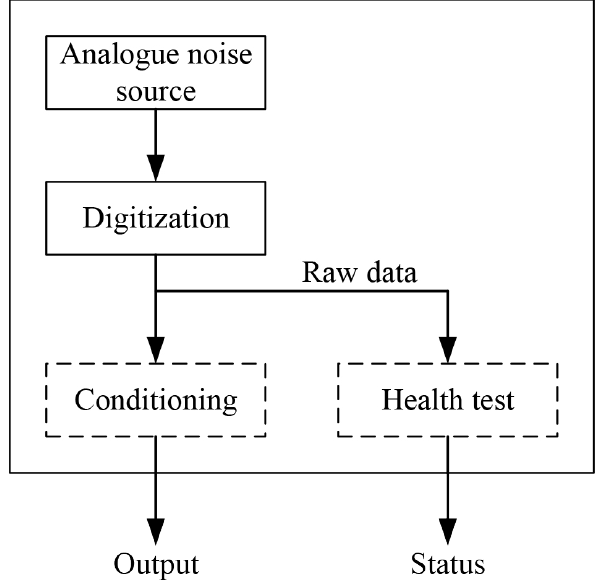
Figure 3. Overall implementation model for the application of the NIST